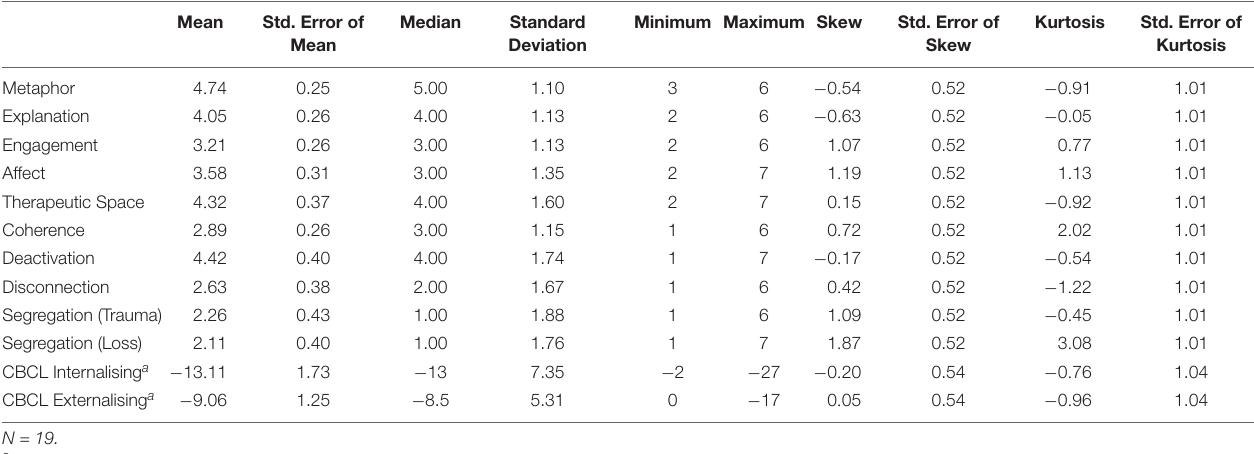
TABLE 1 | Descriptive statistics for the therapist variables (Metaphor, Explanation, Engagement, Affect, and Therapeutic Space), family discourse variables [Coherence, Deactivation, Disconnection, Segregation (Trauma), and Segregation (Loss)], and the change scores (CBCL Internalising and CBCL Externalising).